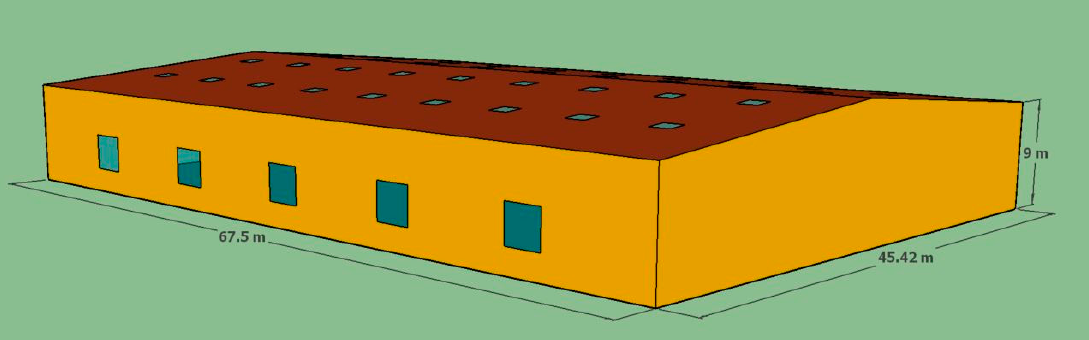
Figure 5. SketchUp model of the case study building.